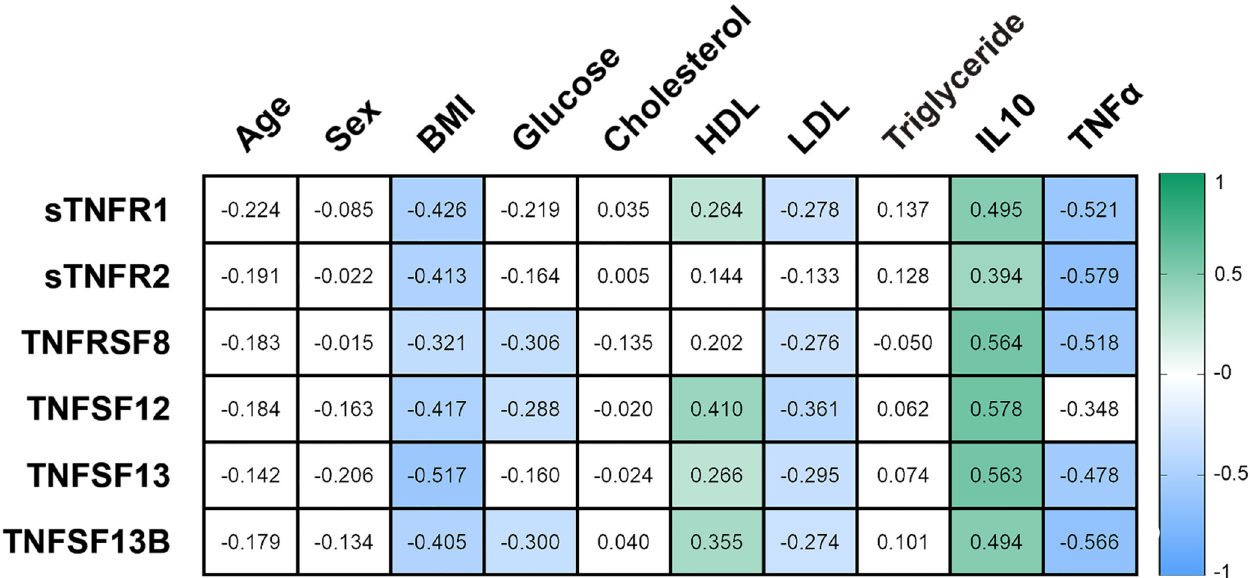
Figure 3. Correlation relationships between sTNF-R1, sTNFRSF8, and ligands—TNFSF12, TNFSF13, TNFSF13B. Filled squares show significance ( p < 0.05). A regression analysis was performed to prove that an increase in TNF class 2 recep- tors and ligands in blood plasma was not randomly associated with an improvement in carbohydrate and lipid metabolism parameters in the serum of obese patients. We ana- lyzed whether the receptors affect the biochemical parameters of obese patients (Figure 4) (Table 3). Using multivariate regression analysis, we showed that an increase in sTNF-R1, TNFSF12, and TNFSF13B levels decreased BMI and plasma glucose levels. Multivariate